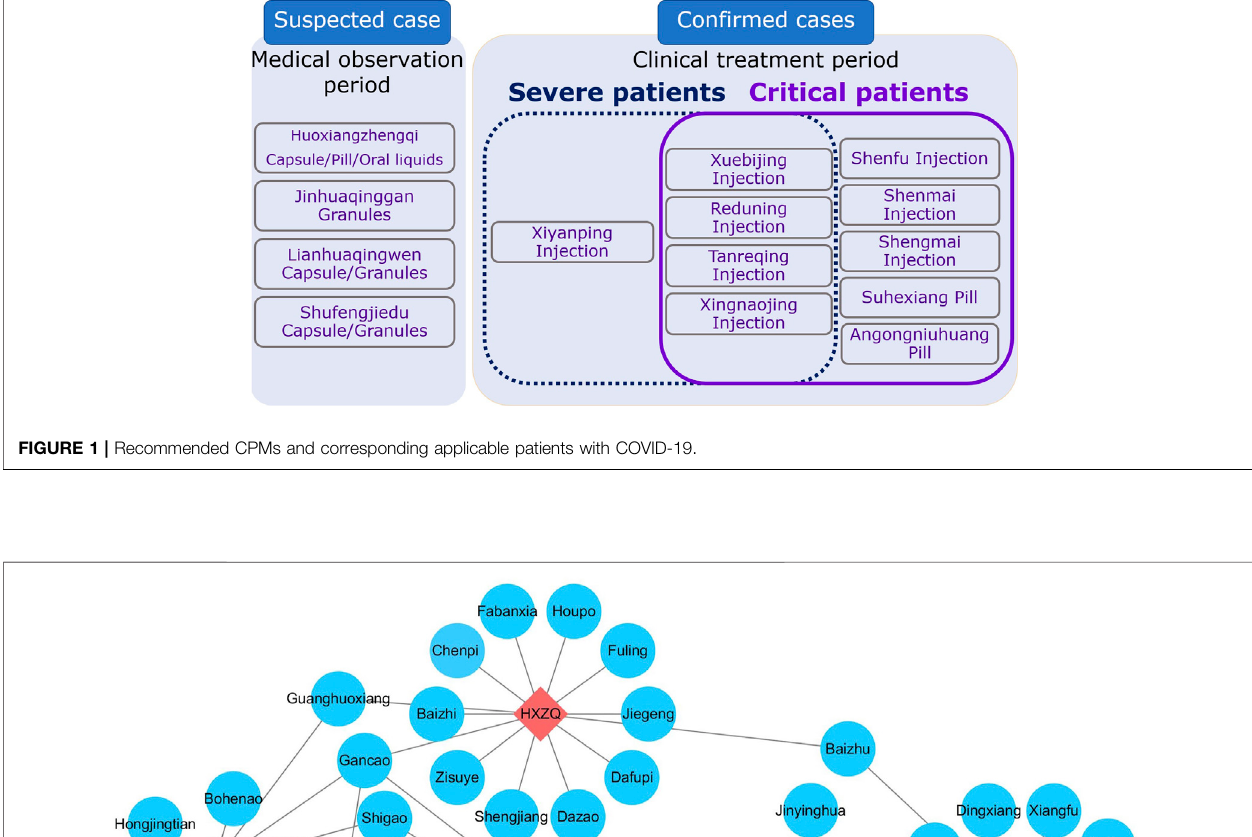
Frontiers in Pharmacology |